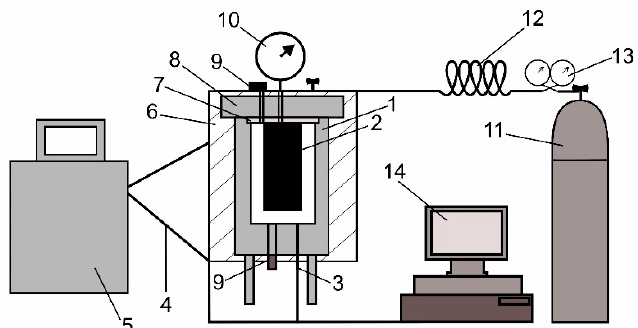
Figure 1. Scheme of experimental setup for modeling the formation and dissociation of pore gas hydrates. 1 = pressure cell; 2 = container with soil samples; 3 = thermistor input sleeve; 4 = hose for circulating liquid; 5 = refrigerated bath; 6 = “thermal coat”; 7 = tephlon gasket; 8 = steel lid; 9 = pressure sensors; 10 = digital pressure gage; 11 = gas bomb; 12 = gas tube; 13 = pressure regulator; and 14 = PC with ADC.